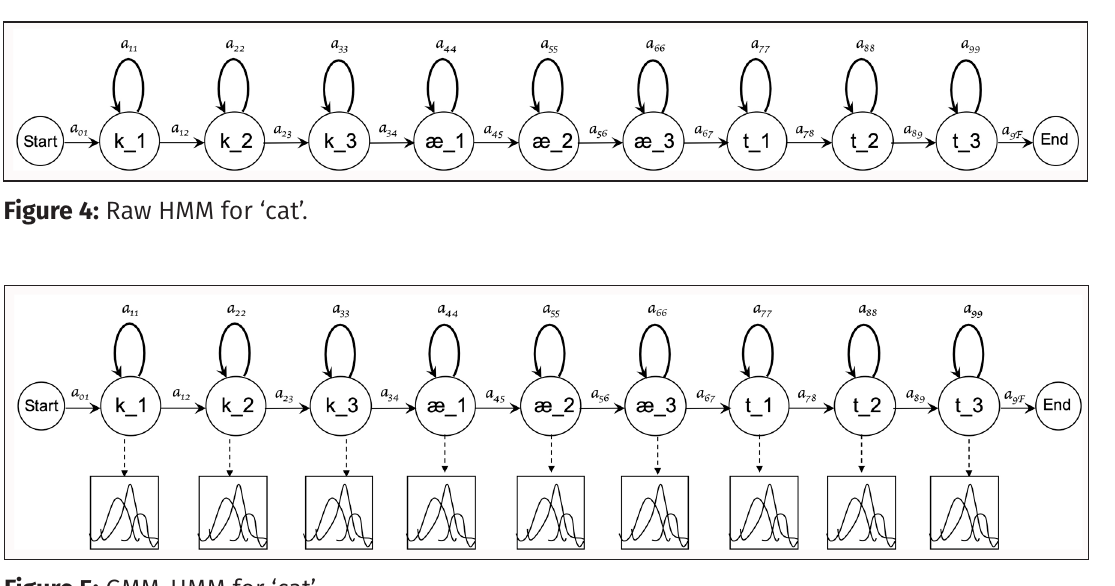
Figure 5: GMM-HMM for